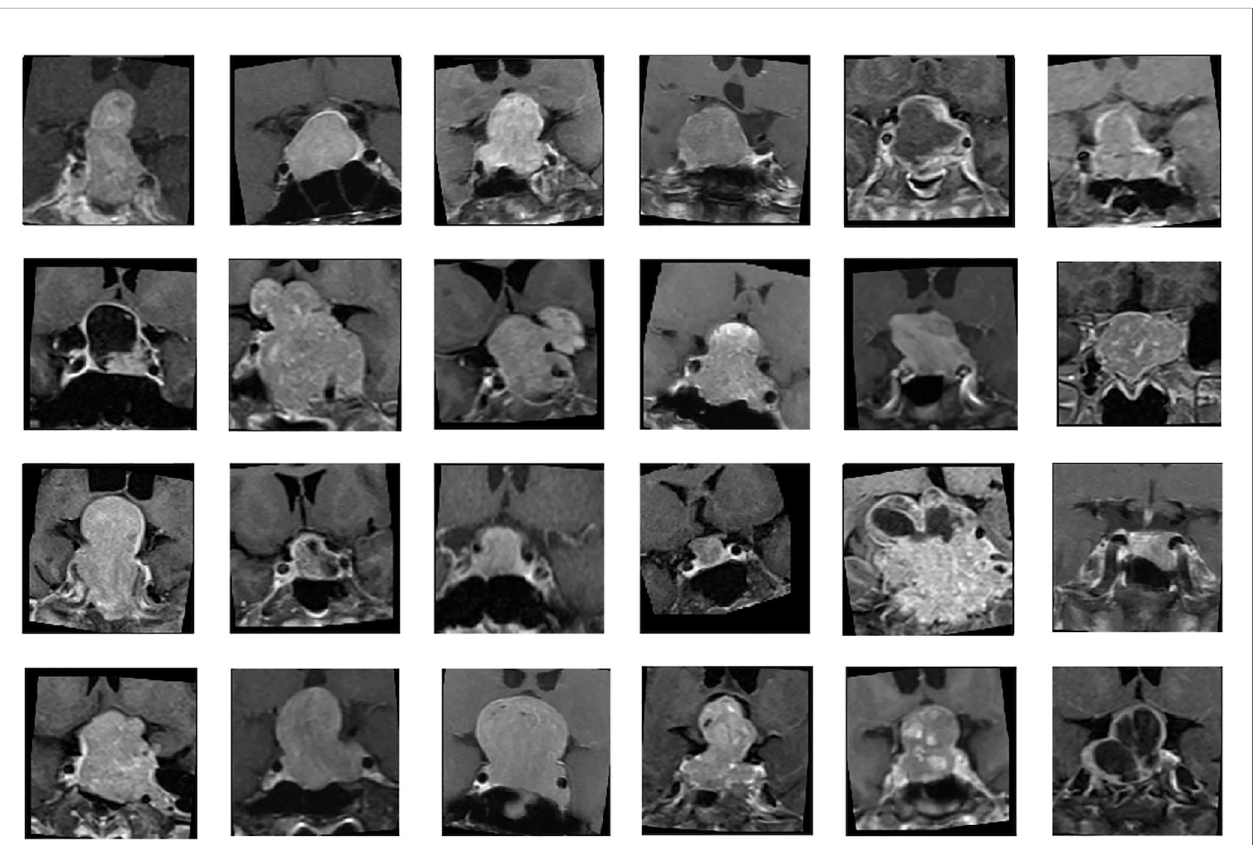
FIGURE 1 | Samples of nonfunctioning pituitary macroadenomas (NFMAs) on coronal contrast-enhanced (CE) T1WI analyzed in CNN